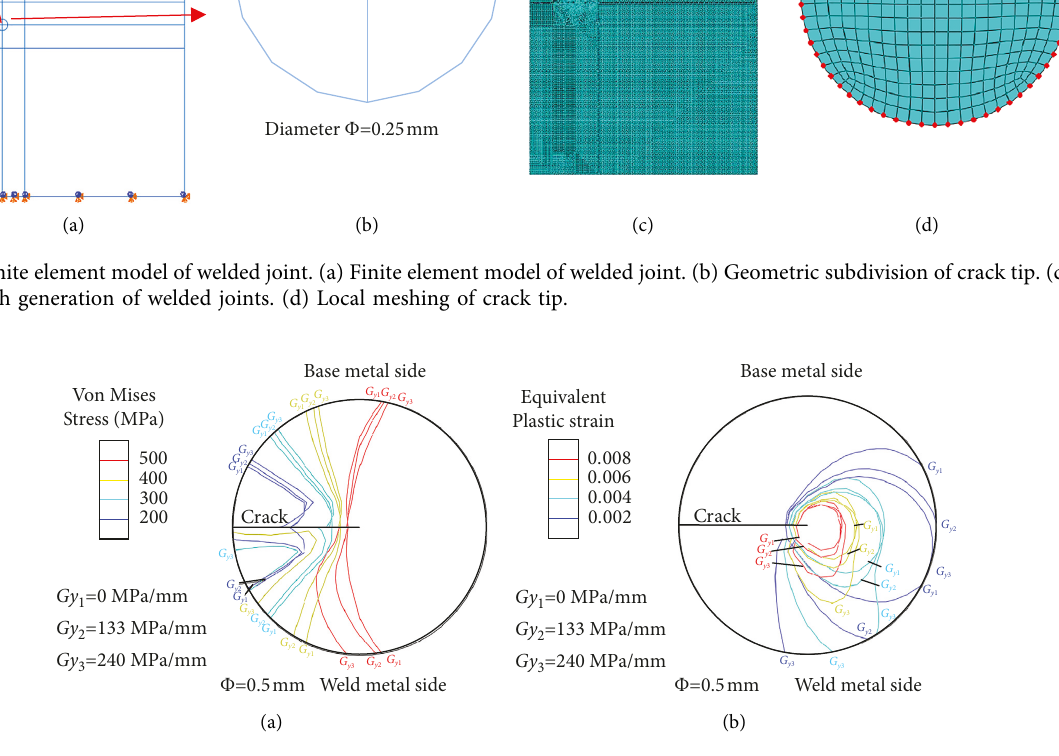
Figure 4: Contour of the USDFLD subroutine welded joint model whose yield strength changes in the y -direction. (a) Von Mises stress contour at crack tip. (b) Equivalent plastic strain contour at crack tip.